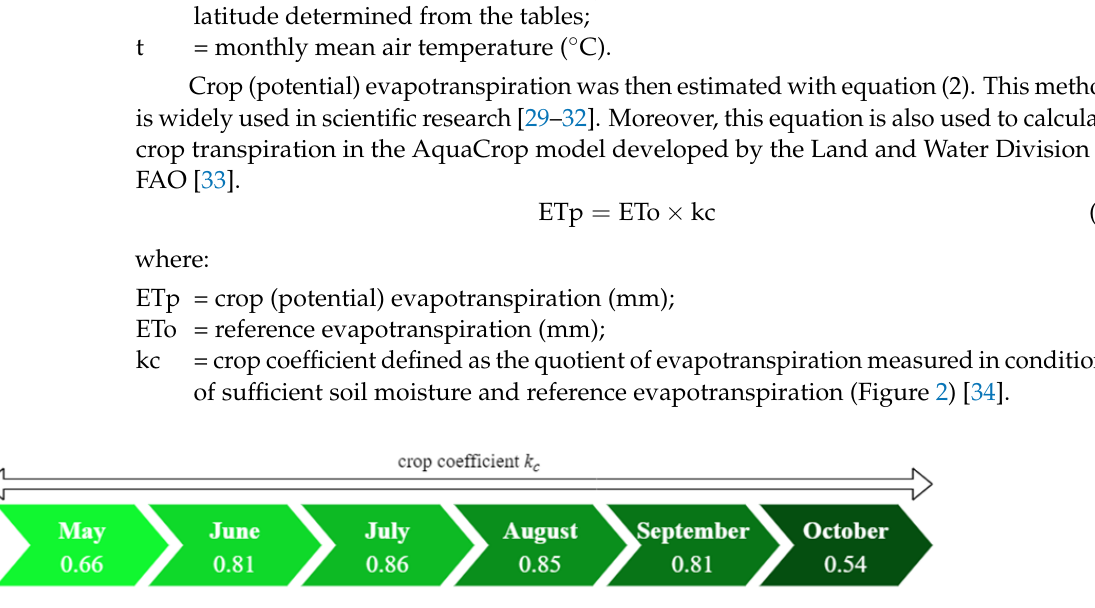
Figure 2. Crop coefficient for the Blaney-Criddle equation for willow depending on the month [34].